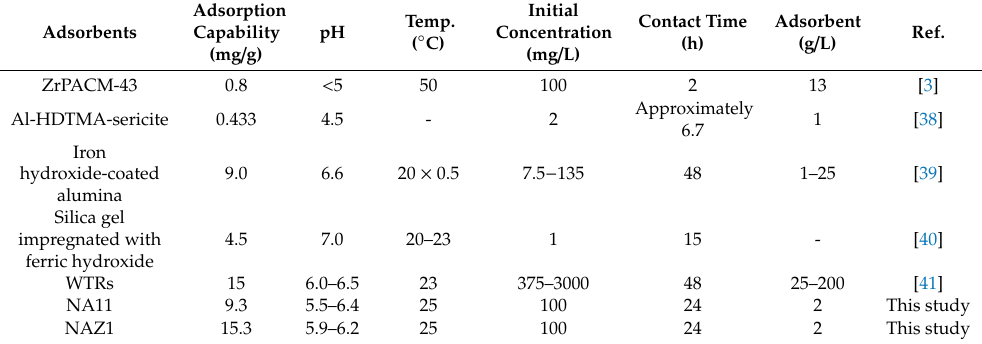
Table 4. Comparison of As(III) adsorption capacity of NA11 and NAZ1 with other reported adsorbents.